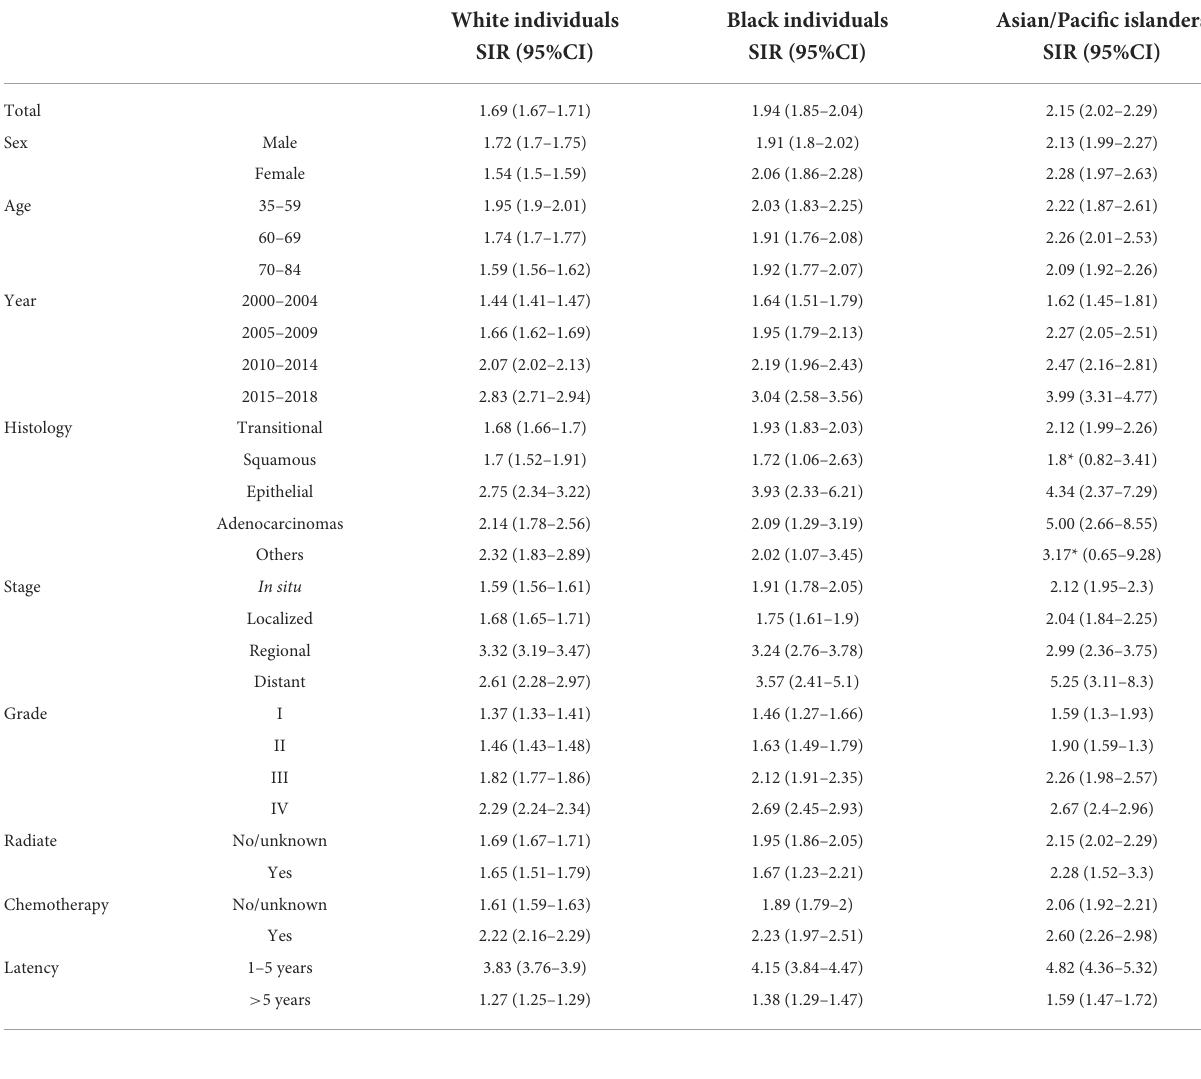
TABLE 3 SPM cases by race using the SIR, with 95% CI; * : p > 0.05.